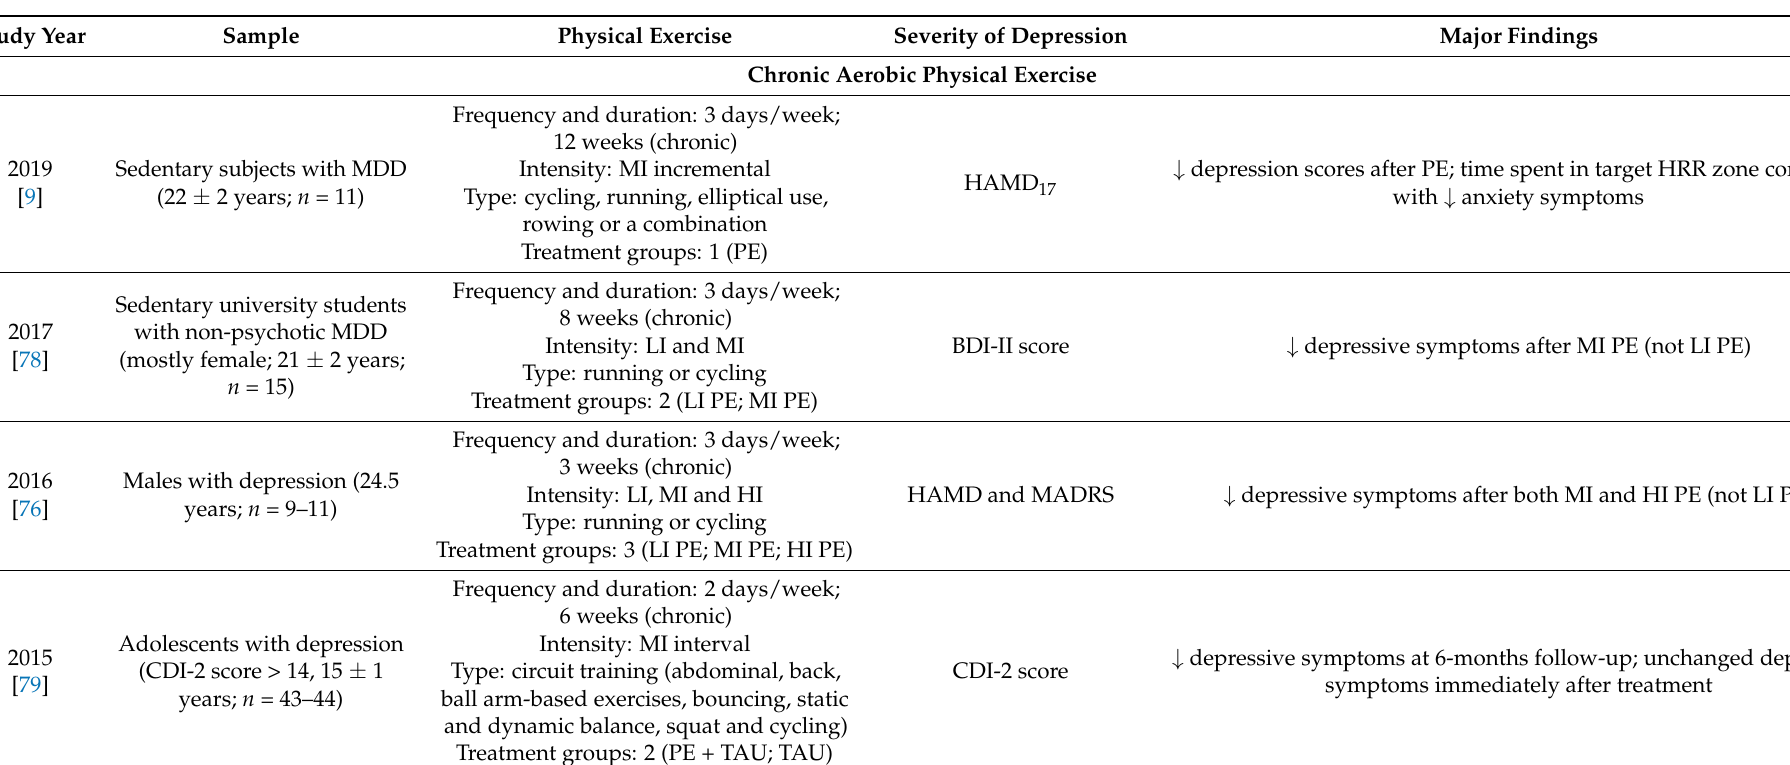
Table 1. Aerobic physical exercise effects on depressive symptoms of subjects with depressive disorder (Diagnostic and Statistical Manual of Mental Disorders (DSM-5) or similar). Study